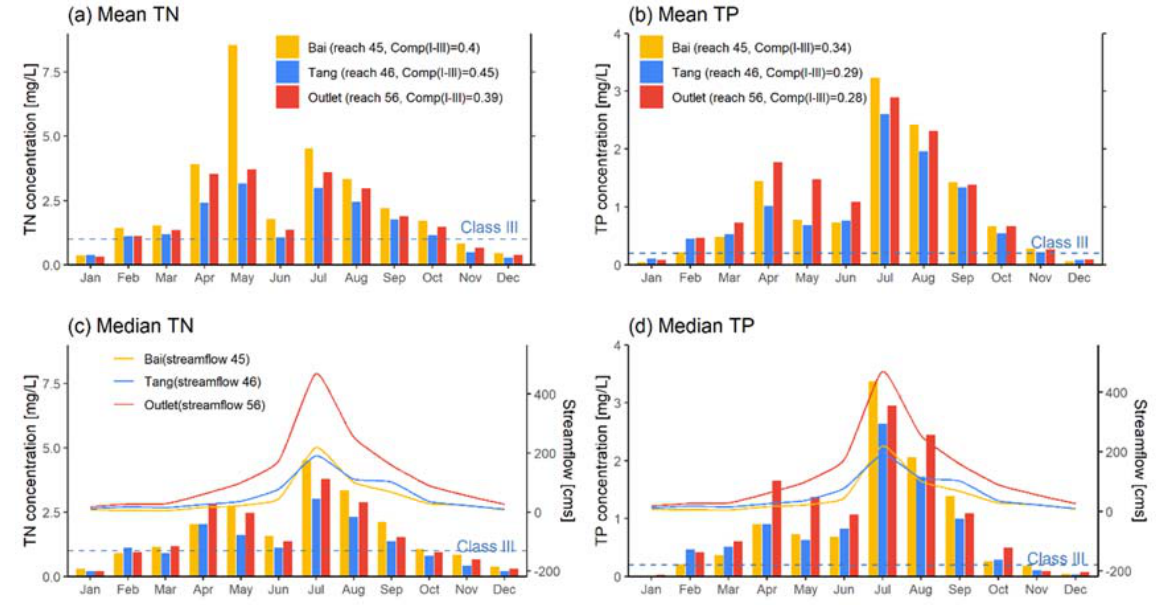
Figure 6. Mean and median values of monthly TN ( a , c ) and TP ( b , d ) concentrations in reaches 45 (Diwan section) on the Bai River, 46 (Bukou section) on the Tang River, and 56 (Zhangwan section) of the watershed outlet. The dashed horizontal lines are the respective concentrations of water quality Class III. The three curves in ( c , d ) are SWAT-simulated mean monthly streamflow for the individual reaches. Comp(I–III) in the legend is the respective compliance rate of Classes I–III water in the period 2000–2019.